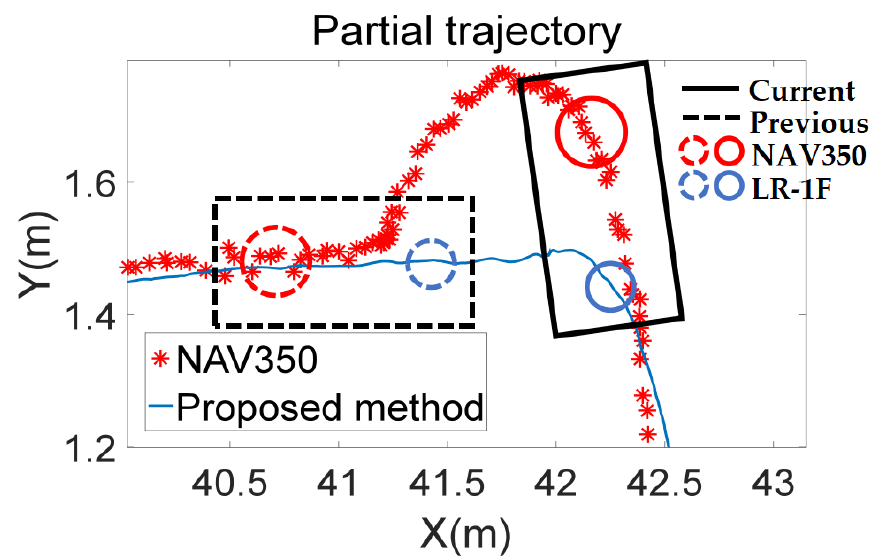
Figure 22. Schematic diagram of the reason for sudden increasing error. The rectangles indicate the positions of the platform at different time stamps. The circles indicate the positions of LiDARs at different time stamps. Dotted lines indicate the previous position and solid lines indicate the current position. The platform rotates with LR-1F as the center during two time stamps.